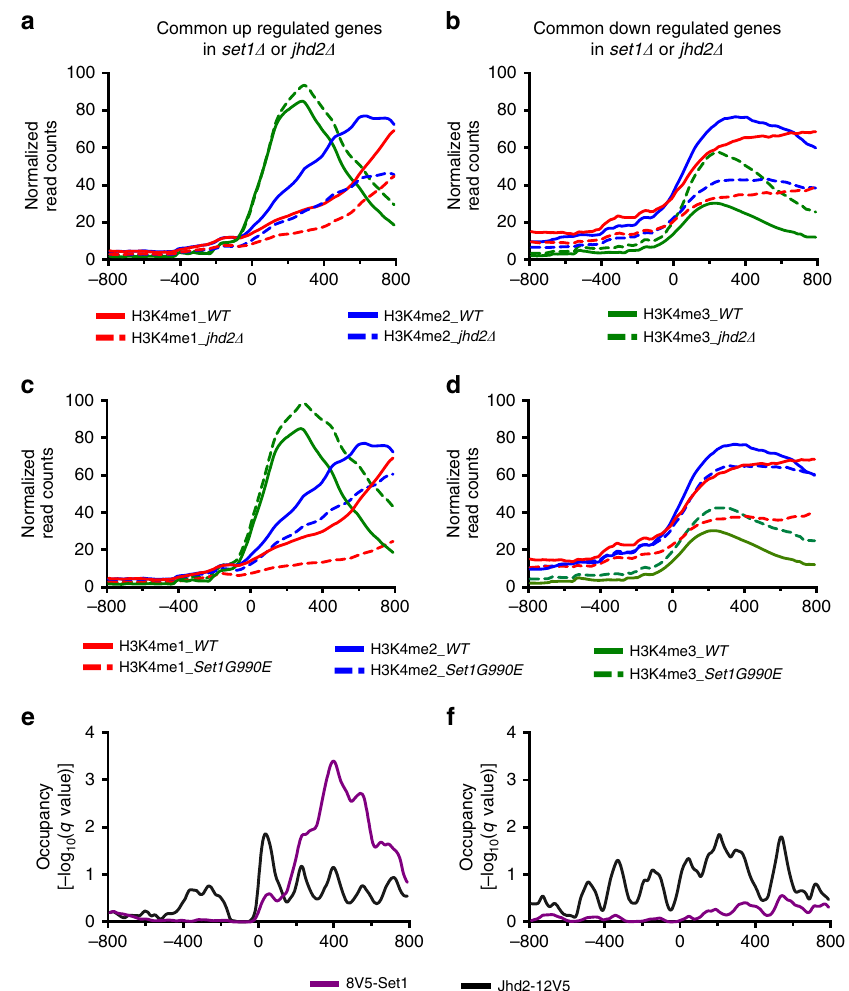
Figure 3 | Set1 and Jhd2 localize to their shared target genes and regulate H3K4 methylation. ( a , b ) Normalized-read counts profiles for H3K4 monomethyl (me1), dimethyl (me2) and trimethyl (me3) marks across 800bp region upstream ( (cid:2) ) or downstream ( þ ) of the TSSs (0) at target genes co-repressed ( a ) or co-activated ( b ) by Set1 and Jhd2 in WT and jhd2 D null mutant. ( c , d ) Normalized-read counts profiles for H3K4me1, H3K4me2 and H4K4me3 marks across regions, as described for ( a , b ), at genes co-repressed ( c ) or co-activated ( d ) by Set1 and Jhd2 in WT and Set1-G990E gain-of-function or hyperactive mutant. ( e , f ) Statistical enrichment (qpois) profiles for 8V5-tagged Set1 or 12V5-tagged Jhd2 occupancies across 800bp region upstream ( (cid:2) ) or downstream ( þ ) of the TSSs (0) at the Set1 and Jhd2 co-repressed ( e ) or co-activated ( f ) target genes. NATURE COMMUNICATIONS|7:11949|DOI: